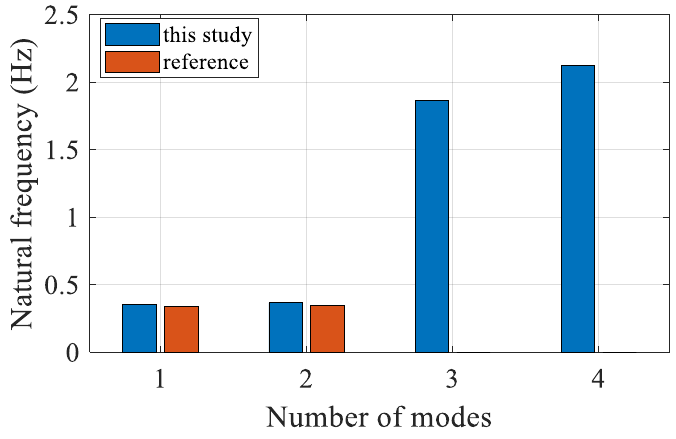
Figure 5. Comparison of natural frequencies of the support structure. In order to find the critical bending direction of the selected 4-leg jacket substructure, extreme environmental loading conditions are considered in the analysis. The environ- mental loads (i.e., wind, wave, and current loads) are selected from the extreme ocean conditions in the West Sea in South Korea, which is chosen for the reference site in this study. The maximum lateral displacements at the top of TP and the maximum stresses at the lower jacket legs are also investigated under the critical DLC loads, which are arranged in a matrix format. The schematic diagram of the loads acting on the 4-leg jacket substructure is graphi- cally shown in Figure 6.